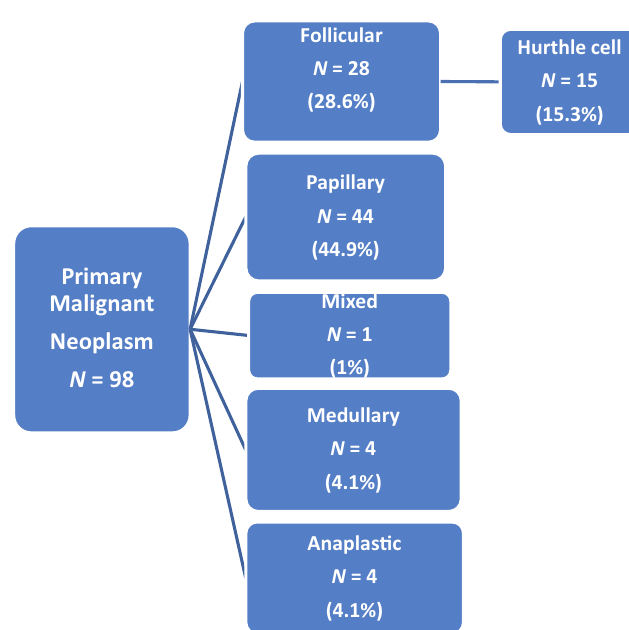
Figure 4 : Primary malignant thyroid disease.